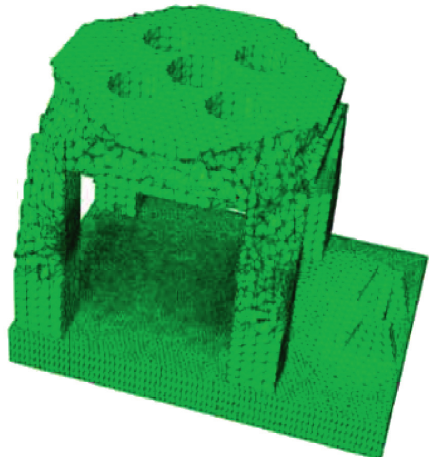
Figure 5: Final result of topology optimization.